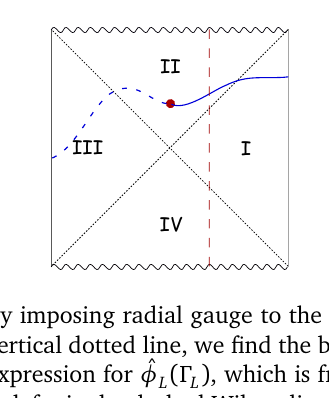
Figure 4: Argument to find the boundary representation of ˆ φ using patchwise radial